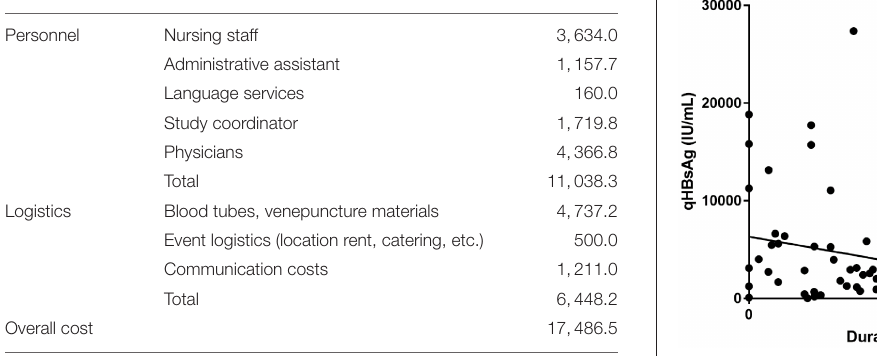
TABLE 3 | Community-based biobanking: costs (in euros).